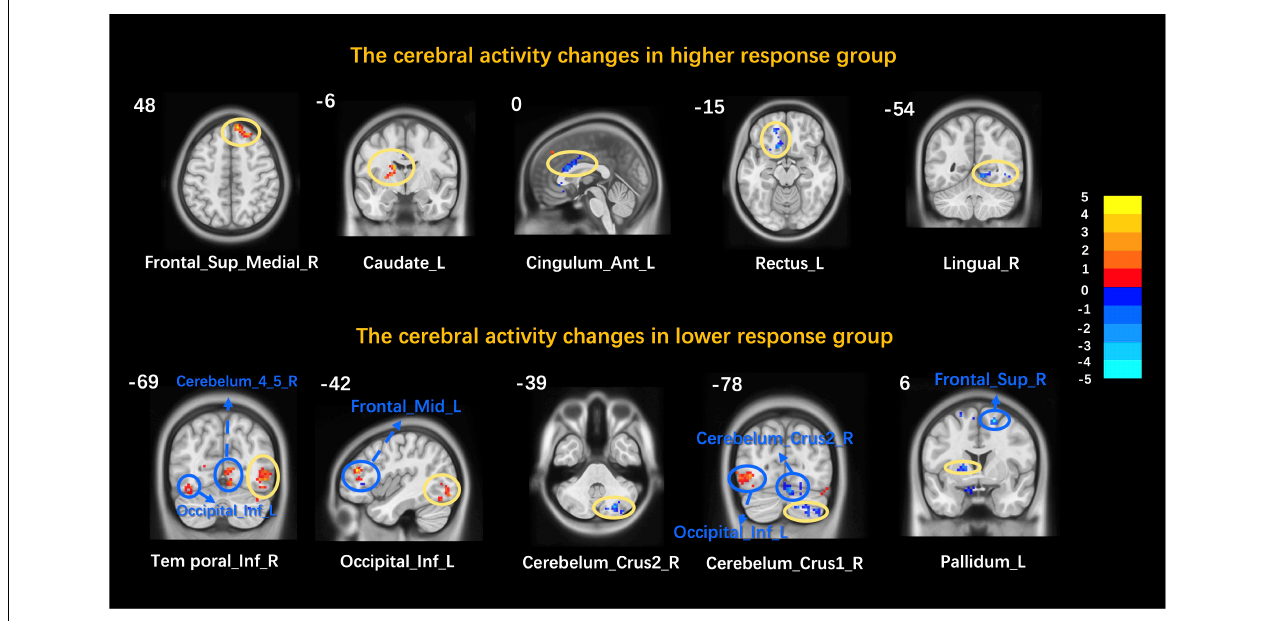
FIGURE 2 | Cerebral activity changes in the higher/lower response group. Frontal_Sup_Medial, medial prefrontal cortex; Cingulum_Ant, anterior cingulate cortex; Lingual, lingual gyrus; Temporal_Inf, inferior temporal gyrus; Occipital_Inf, inferior occipital gyrus; Cerebelum_Crus2, cerebellum inferior; Cerebelum_Crus1, cerebellum superior; L, left; R, right. Yellow circles mark peak points and blue marks non-peak